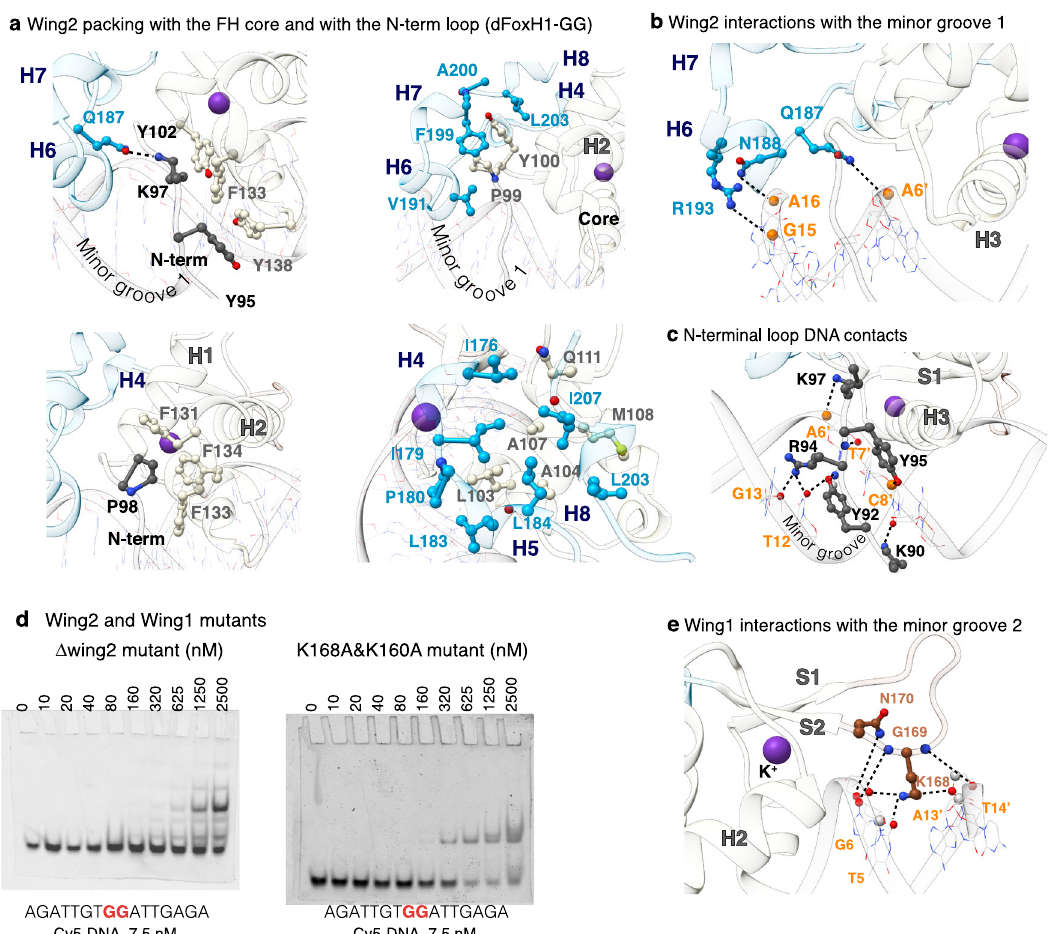
Fig.3 |Minorgrooveinteractions.a FourviewsofWing2andtheN-terminalloop displaying side chain – side chain contacts contributing to the distinctive FoxH1 FH fold.ResiduesarecolorcodedasinFig.2a. b Wing2bindingtominorgroove1.HBs are indicated with dashed lines. Protein residues, nucleotides and